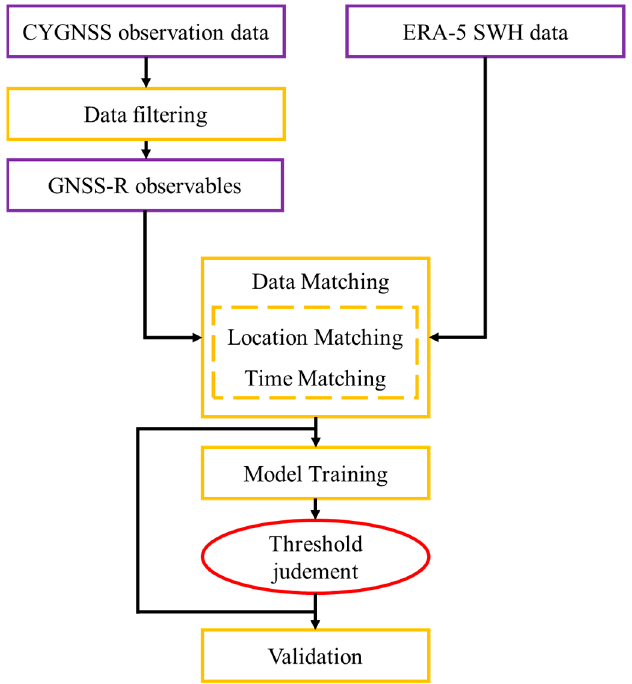
Figure 2. Flow chart of SWH estimation using spaceborne GNSS-R technology in the current